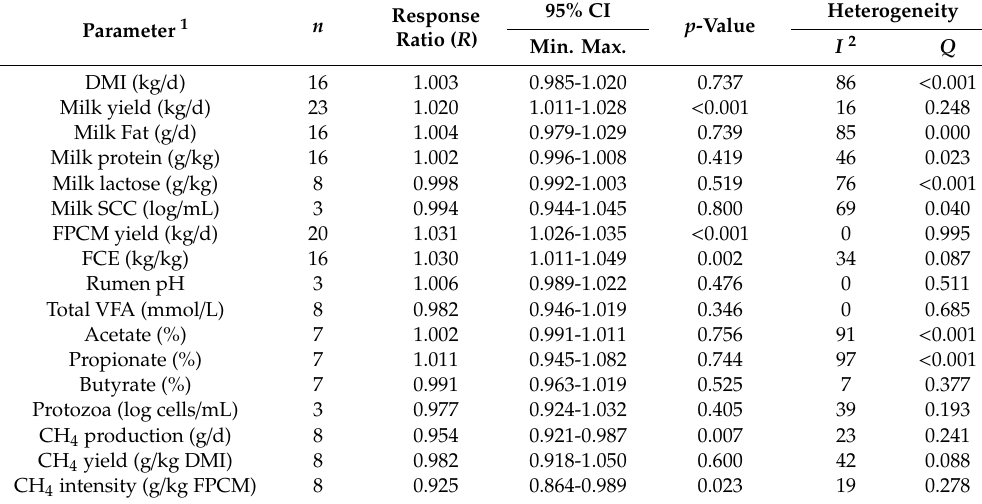
Table 3. Mean response ratio and estimated heterogeneity parameters describing the overall effects of supplementing an essential oil blend (1 g/d per cow) to dairy cows.